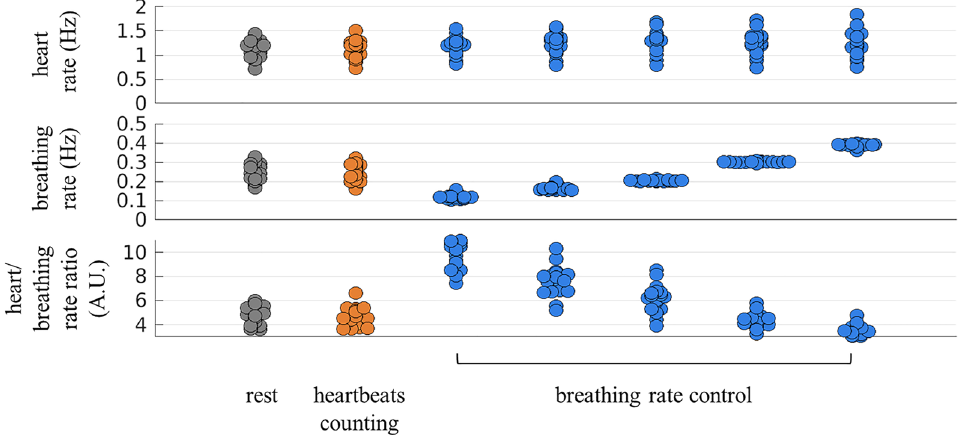
Figure 2. Average heart rate, breathing rate, and heart/breathing rate ratio during the experimental